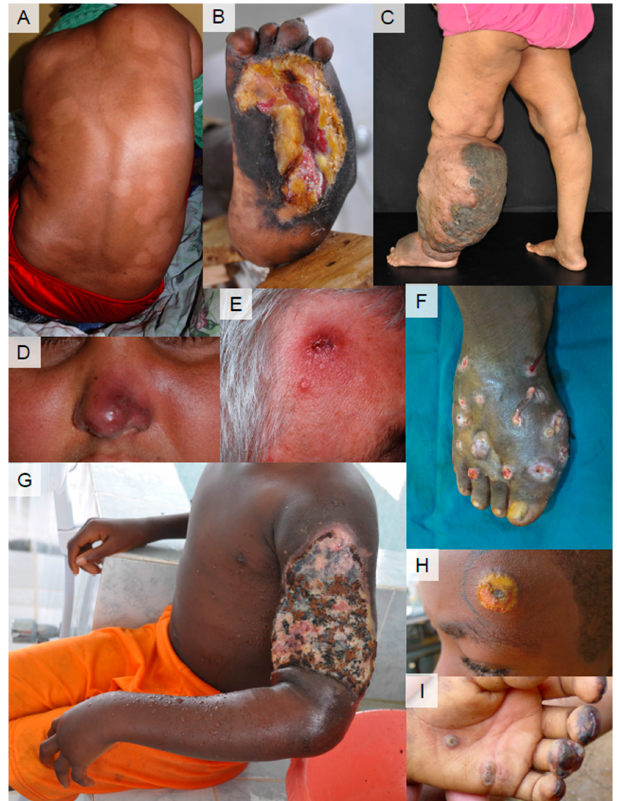
Figure 1. Clinical presentation of skin NTDs. ( A ) Leprosy (borderline tuberculoid leprosy). Ill-defined, multiple hypo-pigmented patches on the back. ( B ) Deformities of the feet and ulcer from peripheral neuropathy in leprosy. ( C ) Lymphatic filariasis. Unilateral lymphedema of the limb. (image: Saravu R. Narahari) ( D ) Mucocutaneous leishmaniasis. Redness and swelling of the nose. Inside: destruction of the nasal mucosa. Same patient as ( A ) (co-infection). ( E ) Cutaneous leishmaniasis. Infiltrated granulomatous lesion with central ulceration on the forehead. ( F ) Mycetoma. Multiple nodules with openings of draining sinuses discharging pus and blood. (image: Ahmed Fahal) ( G ) Buruli ulcer. Ulceration on the arm with extensive edema. Black and yellowish necrotic tissue on wound surface with some traditional remedies at first visit. ( H ) Yaws (primary yaws). Nodule with central ulceration with yellow crust on the forehead. (image: Kingsley Asiedu) ( I ) Tungiasis. Multiple small nodules with central black dot (body part of the adult flea) on the palm and on the finger tips.